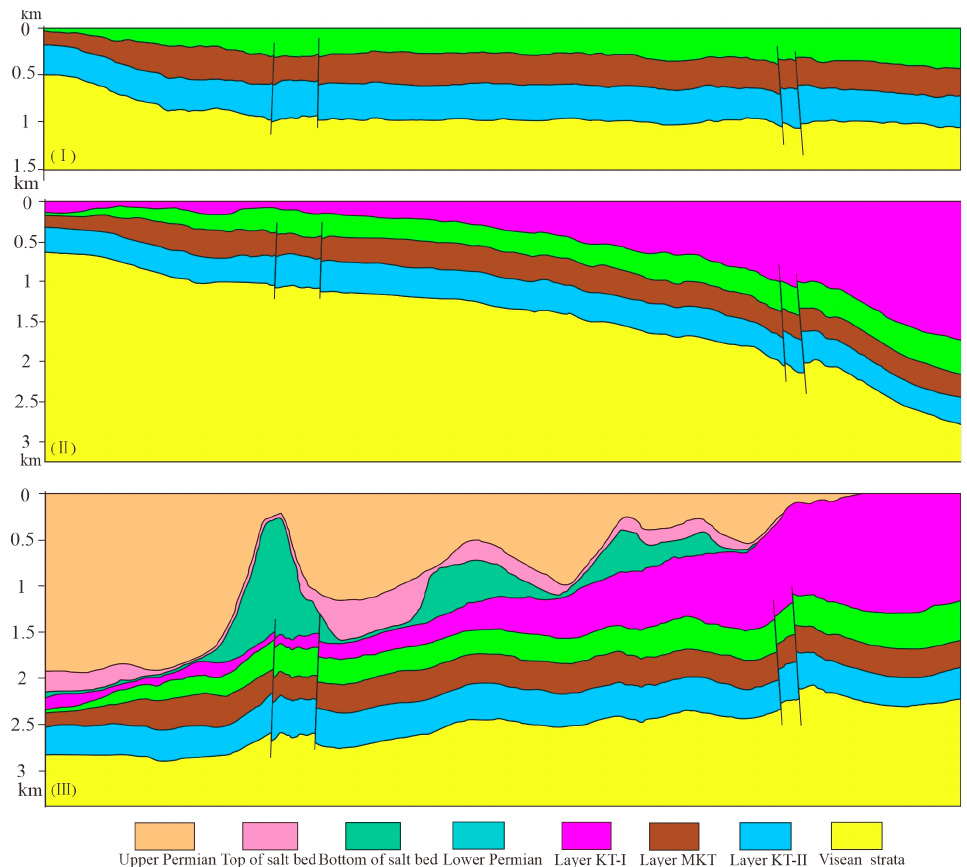
Figure 2. Tectonic evolution of the study area. ( I ) The first-stage tectonic movements in the early Permian. ( II ) The second-stage tectonic movements in the late Permian. ( III ) The third-stage tectonic movements in the